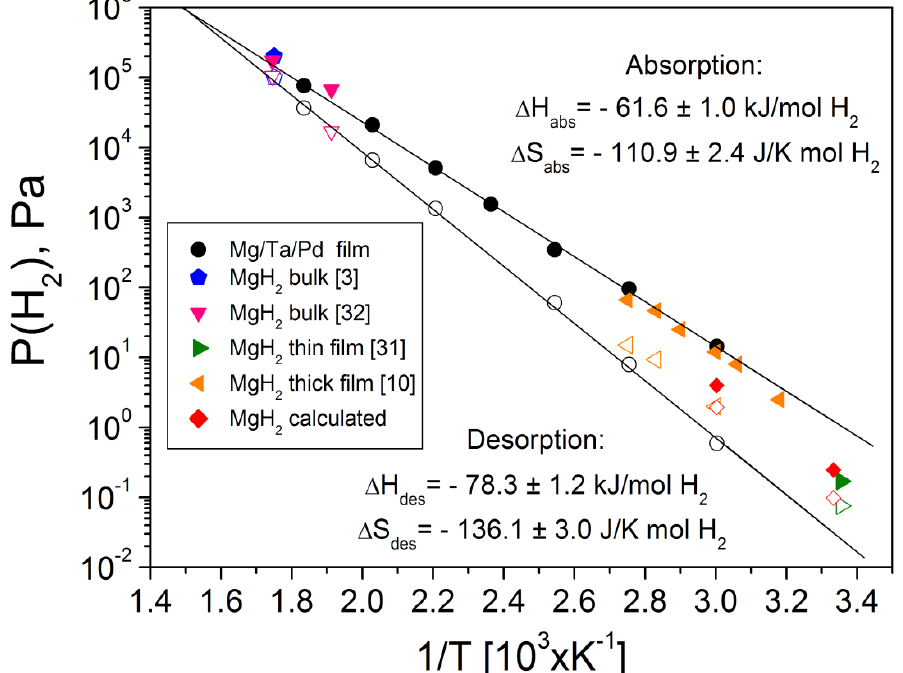
Figure 2. Van't Hoff plot of the Mg/Ta/Pd films. Filled and open symbols represent absorption and desorption, respectively. Thermodynamic parameters are calculated from the regression analysis. Data for bulk MgH [3] and MgH –V 3at.%–Ti 2at.% [26], 2 2 thin [24] and thick MgH films [25] are shown for comparison. Red diamonds are the 2 calculated absorption and desorption equilibrium pressures from the Van't Hoff equation using Pedersen [22] and Stampfer [11] thermodynamic parameters,